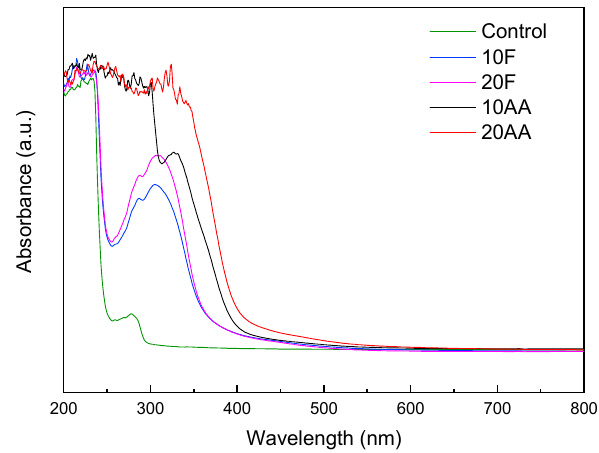
Figure 2. UV-vis spectra of fish gelatin films as a function of cross-linker type and content.